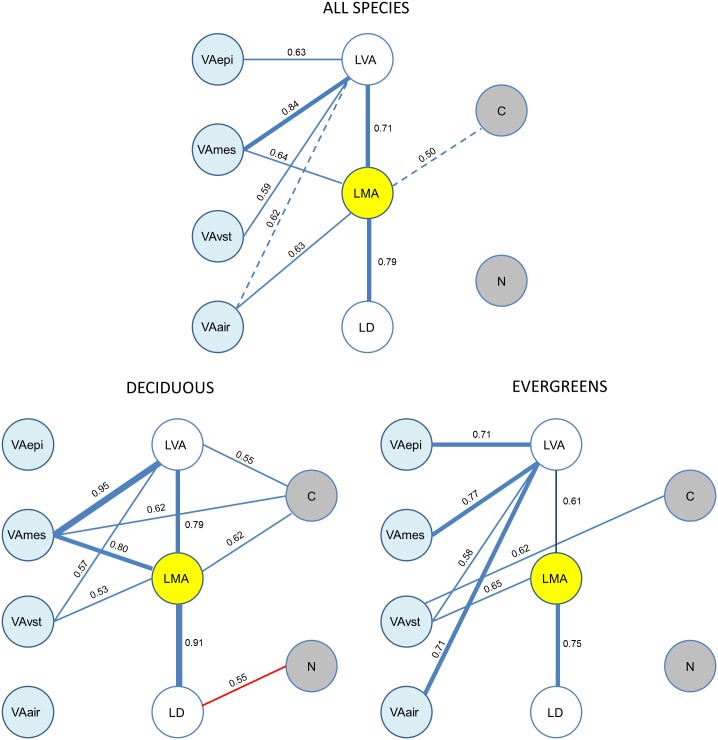
Correlation network for morphological (white), anatomical (blue) and chemical traits (grey), describing the interrelations with LMA (yellow).Blue lines indicate positive correlations and red lines negative correlations. Dashed lines indicate phylogenetic independence. The correlation coefficient is shown. Thin lines, 0.5<|r|<0.707 (0.25<R2<0.50); intermediate lines, 0.707<|r|< 0.866 (0.50<R2<0.75); bold lines, |r|>0.866 (R2>0.75).